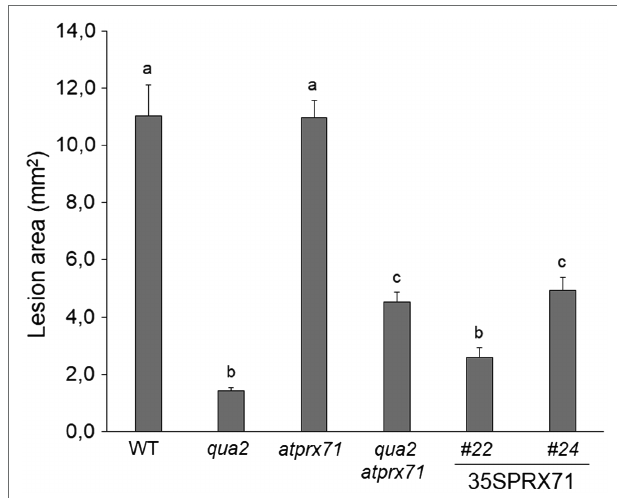
FIGURE 6 | Resistance to B. cinerea in qua2 is partially dependent on AtPRX71 . Rosette leaves of five-week-old WT plants, qua2, atprx71 , and qua2 atprx71 plants, and of two independent transgenic lines overexpressing AtPRX71 (35SPRX71 #22 and #24) were inoculated with a B. cinerea spore suspension, and lesion area was measured 2 days after inoculation ( n > 10 for each genotype). Bars indicate average lesion area ± SE . Different letters indicate statistically significant differences, according to one-way ANOVA followed by Tukey’s significance test ( p <